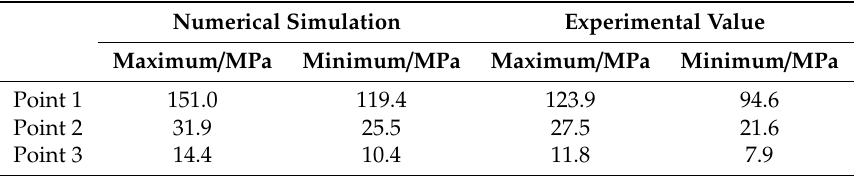
Table 2. Comparison between numerical results and experimental results for dynamic